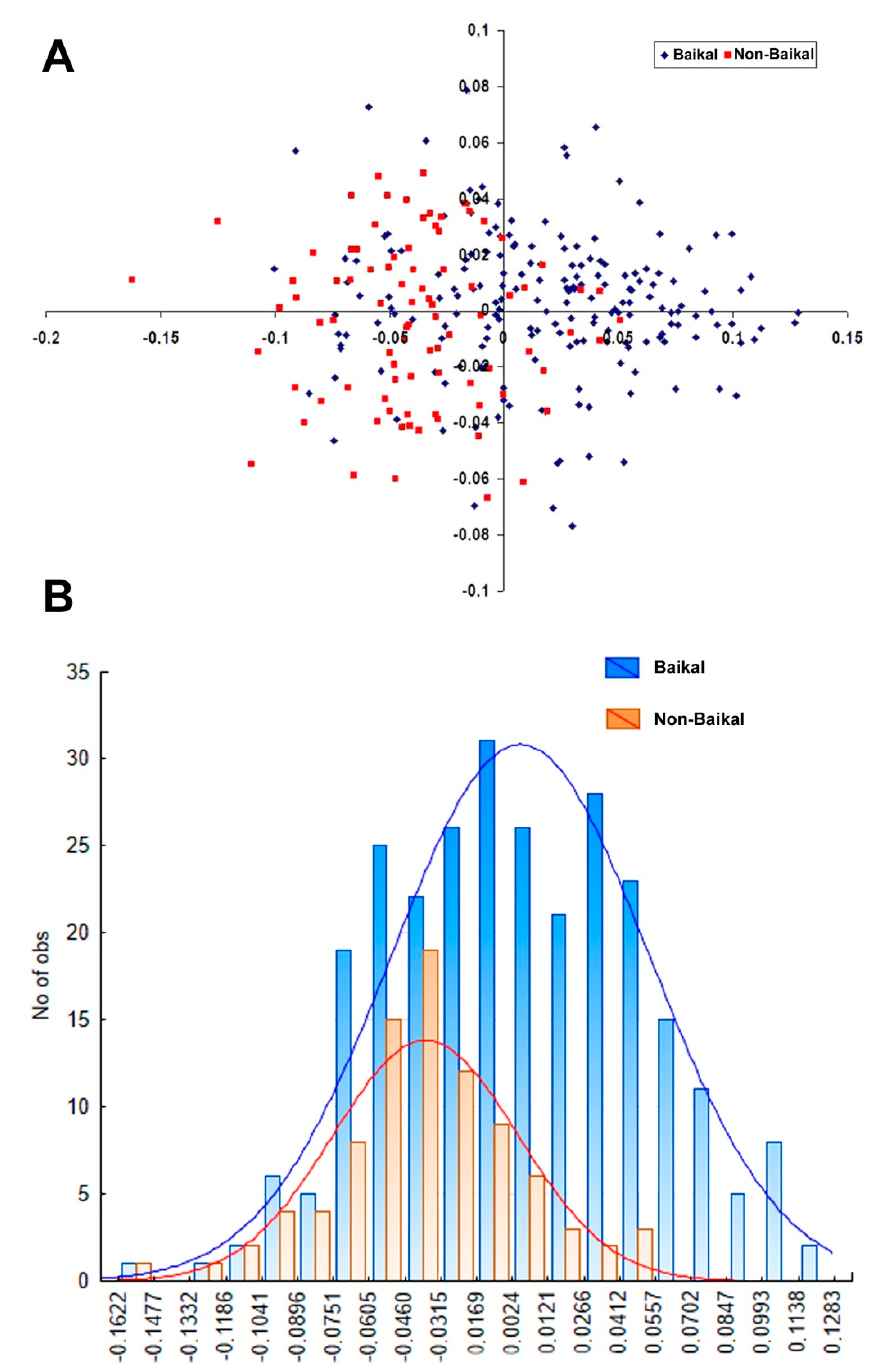
Figure 12. ( A ) Positions of the Baikalian and non-Baikalian specimens of R. auricularia in the space formed by the first two RWs. ( B ) Distribution of the first RW values in the Baikalian and non-Baikalian specimens of R. auricularia .